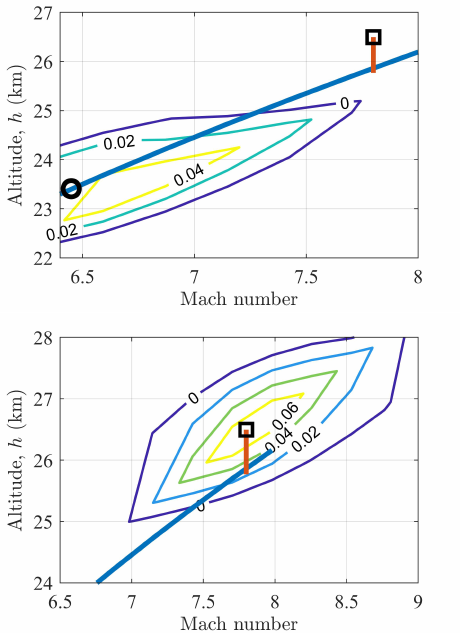
Figure 9. Gap margin of ascent